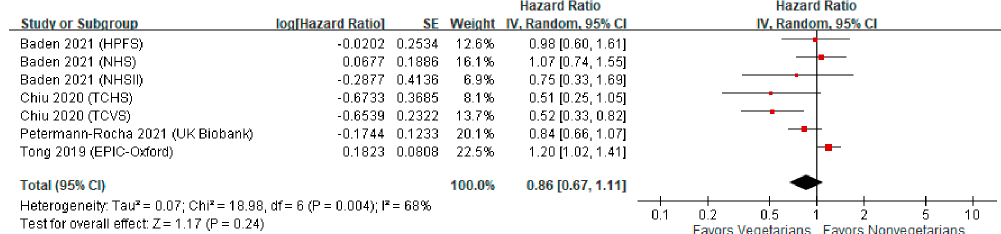
Figure 1. Forest plot showing the association of a vegetarian diet and the risk of incident stroke. The meta-analysis illustrated no association between a vegetarian diet and the risk of incident stroke. CI, confidence interval; IV, inverse variance; SE, standard error.